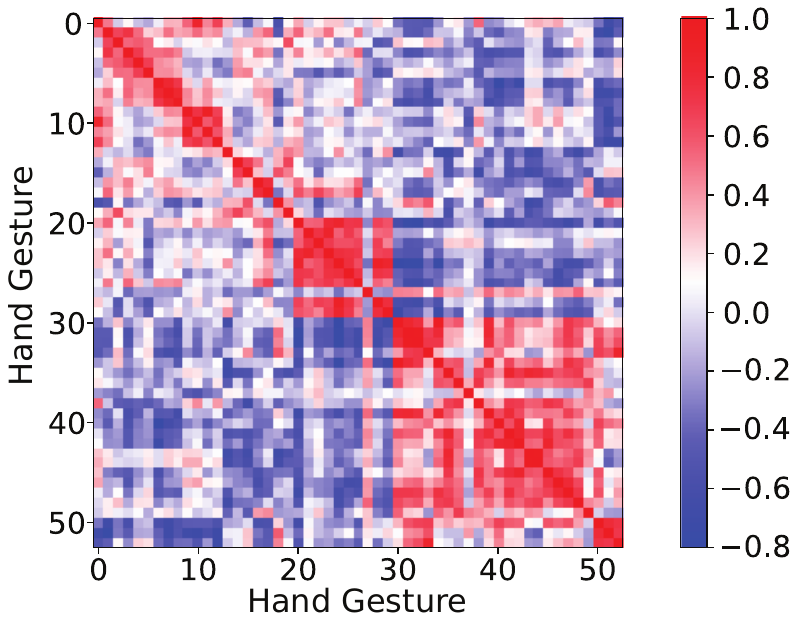
Figure 9. Correlation matrix for the proposed